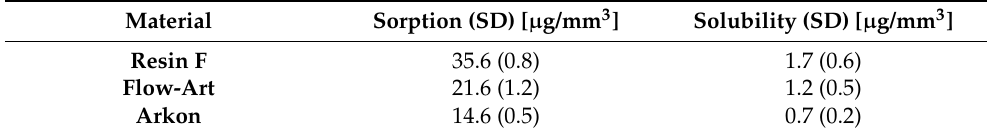
Table 2. Mean sorption and solubility for Resin F, Flow-Art and Arkon materials with standard deviation (SD). Sorption and solubility were determined according to the ISO 4049